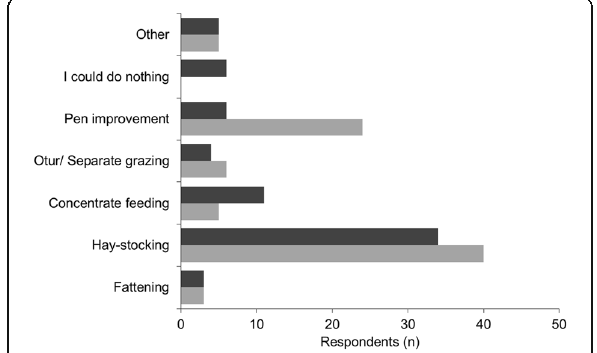
Figure 2 Protective strategies actually implemented against the 2009/10 dzud ( dark grey ) and measures perceived necessary ( light grey ) by 50 interviewed herder households in the Mongolian Altai. Multiple answers were possible